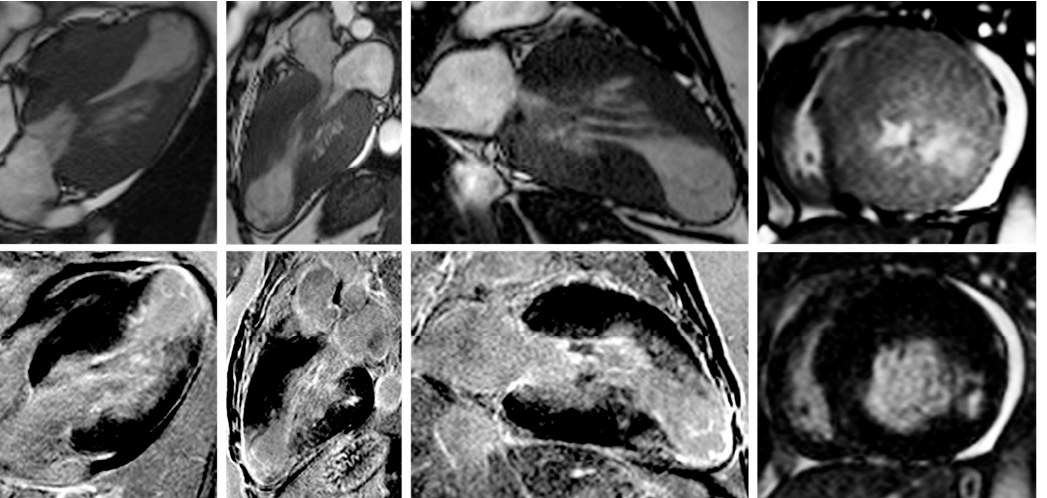
Figure 3. Contrast-enhanced cardiovascular magnetic resonance imaging in a 32-year-old male patient with a history of hypertrophic cardiomyopathy due to a pathogenic mutation in MYBPC3 gene (c.772G>A) (from the own collection of the authors). The current findings are compatible with a phenotype of burn-out HCM. ( Upper row ): b-SSFP cine images in two, four and three chambers, and short axis, respectively. The LV is severely dilated (166 mL/m2) with severe systolic dysfunction (LVEF 22%). Currently, there is no LV outflow tract obstruction, although an obstructive phenotype was diagnosed 10 years before. ( Lower row ): LGE imaging shows extensive heterogeneous replacement myocardial fibrosis at the level of the interventricular septum, anterior and inferior LV walls, respectively. Also note the fibrosis of the papillary mitral muscles. Abbreviations: b-SSFP, balanced steady-state free precession; CMR, cardiac magnetic resonance imaging; LVEF, left ventricle ejection fraction; LGE, late gadolinium enhancement; LV, left ventricle.